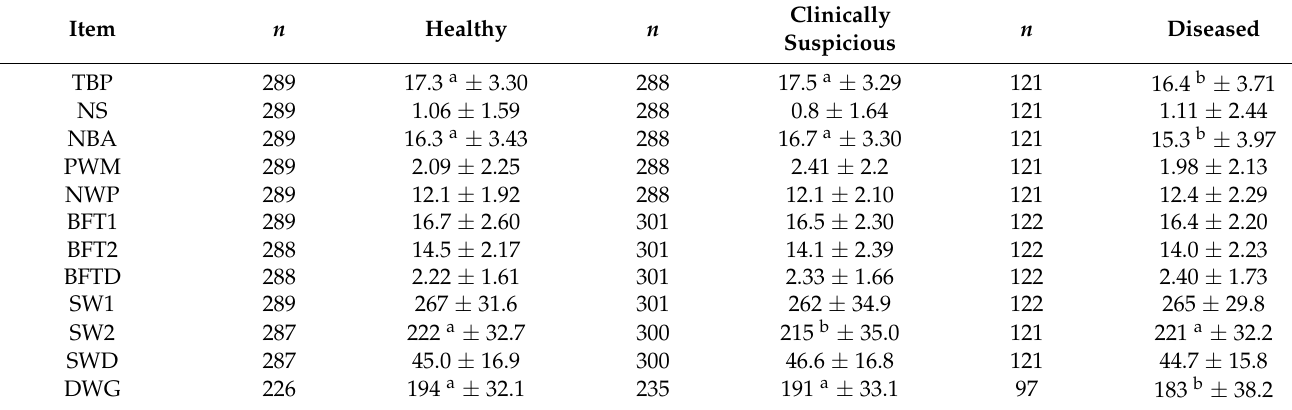
Table 3. Comparison of performance parameters between healthy, clinically suspicious and diseased sows.